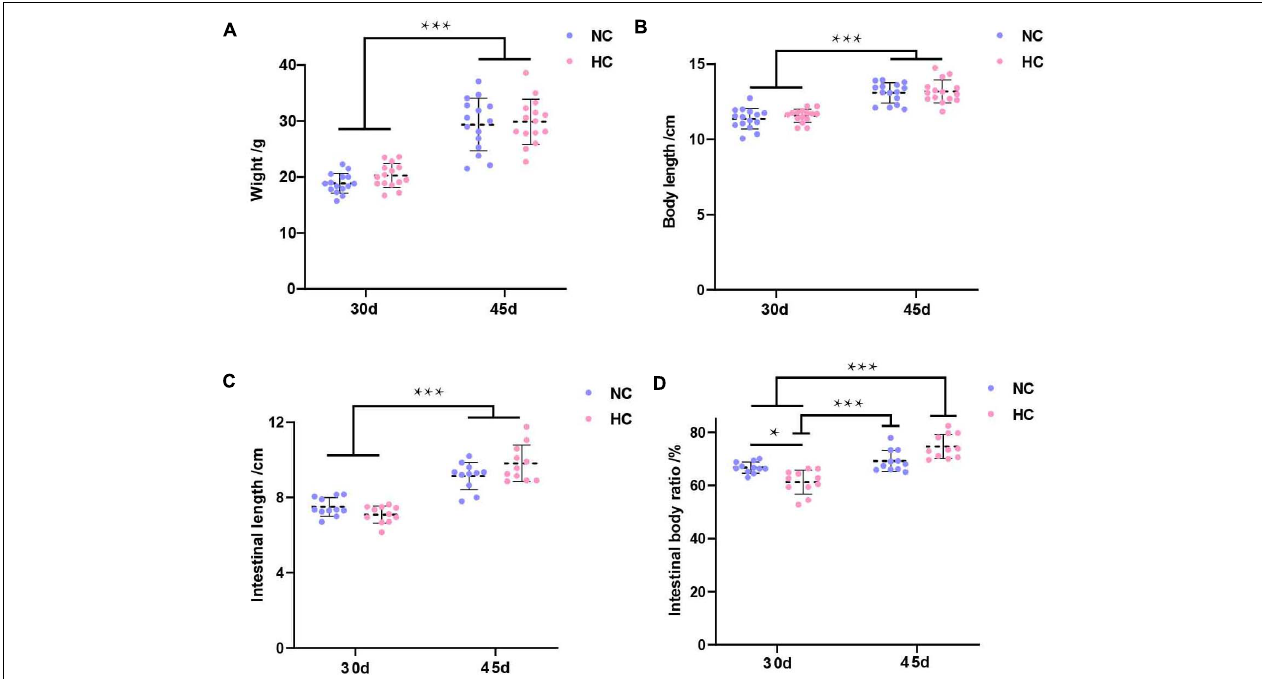
FIGURE 1 | Growth performance of largemouth bass (A–D) Weight, body length, intestinal length, and intestinal body ratio of largemouth bass after 30 and 45 days, respectively (* P < 0.05; *** P < 0.001. NC: 0% α -starch diet, HC: 22% α -starch diet).